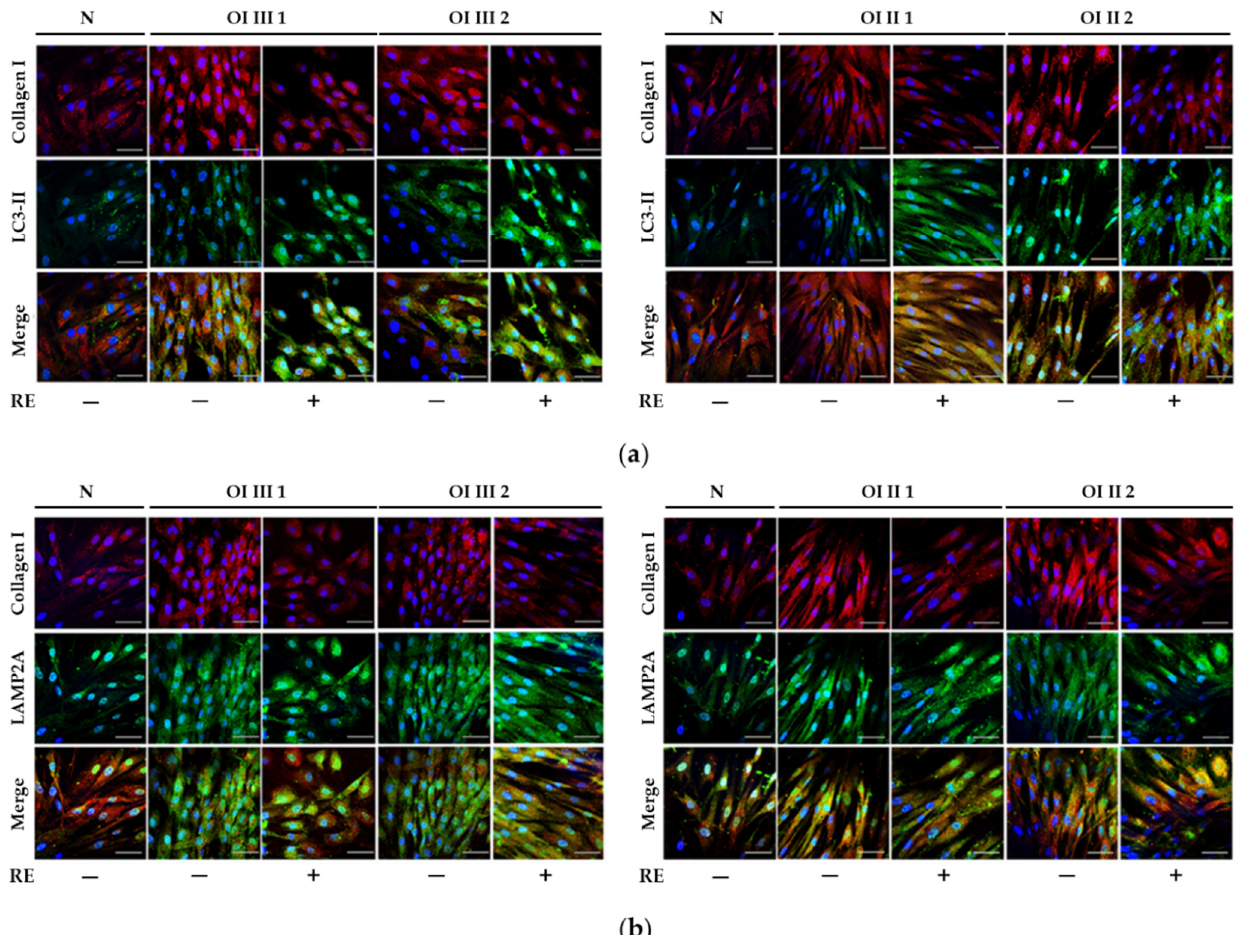
Figure 6. Colocalization of collagen type I (red)/LC3-II (green) ( a ), and of collagen type I (red)/LAMP2 (green) ( b ), and changes in the intensity of staining of these proteins in normal (N) and OI types III and II cells, treated with 50 µg/mL rosemary extract (RE), revealed by confocal microscopy analysis. A merge signals of colocalizing collagen type I/LC3-II and collagen type I (/LAMP2 were detectable, with greater intensity in RE-treated cells. Nuclei were stained with DAPI (blue). Scale bar, 50 µm. Representative immunofluorescent images are shown.